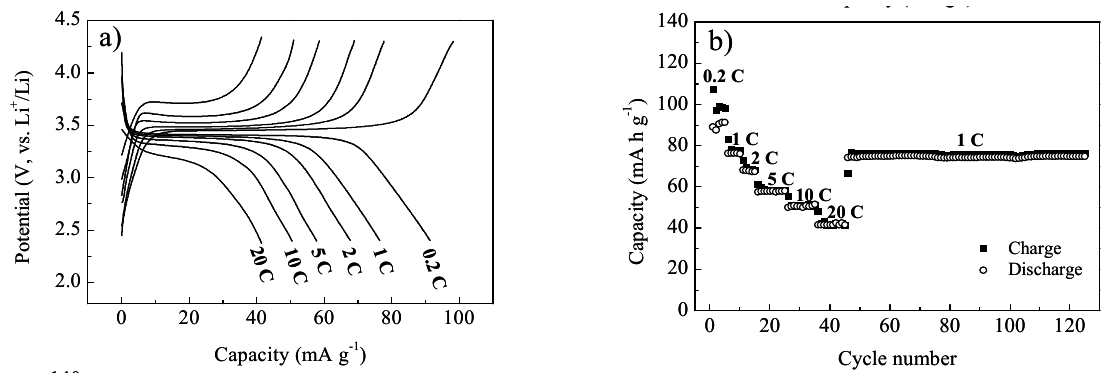
Figure 6. Electrochemical properties of LFP250-1-700. ( a ) Galvanostatic charge/discharge curves at different rates; and ( b ) corresponding cycling performance. 1 C = 170 mA g − 1